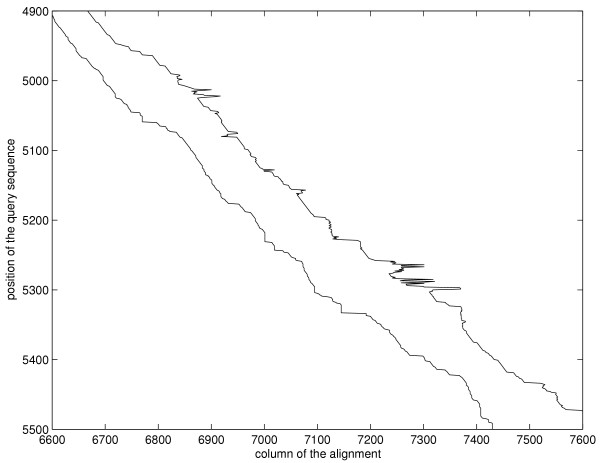
Detailed section of Figure 5.